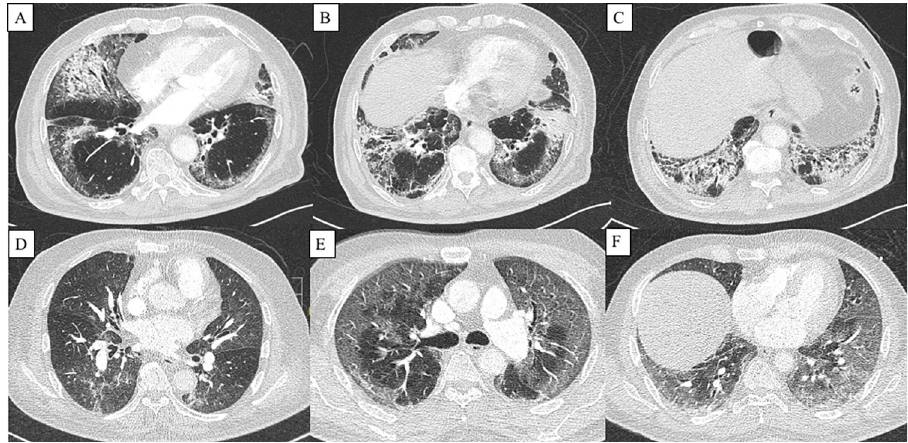
Fig 2. Axial HRCT images. (A, B, C) Organising pneumonia -bilateral bronchocentric consolidation over right middle lobe and left lower lobe extending to subpleural region with perilobular thickening. (D) Bronchopneumonia— multifocal peribronchial patchy consolidation and ground-glass changes. (E, F) Diffuse alveolar damage—diffuse peripheral ground-glass opacities and interlobular